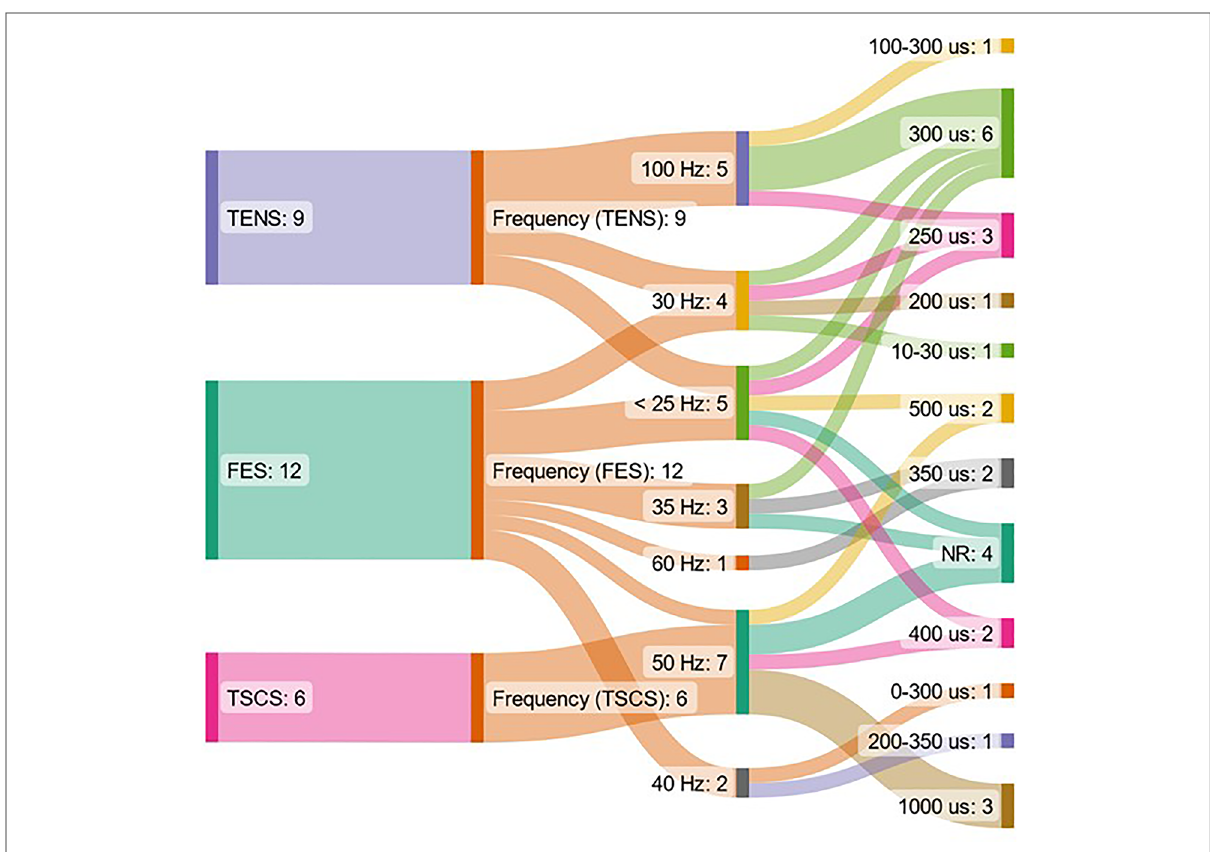
FIGURE 2 Representation of the form of non-invasive ES, frequency and pulse width used in included studies. The fi gure shows data from papers which used a single stimulating frequency which was reported only. ES=electrical stimulation, FES=functional electrical stimulation, NR=not reported, TENS= transcutaneous electrical nerve stimulation, TSCS=transcutaneous spinal cord